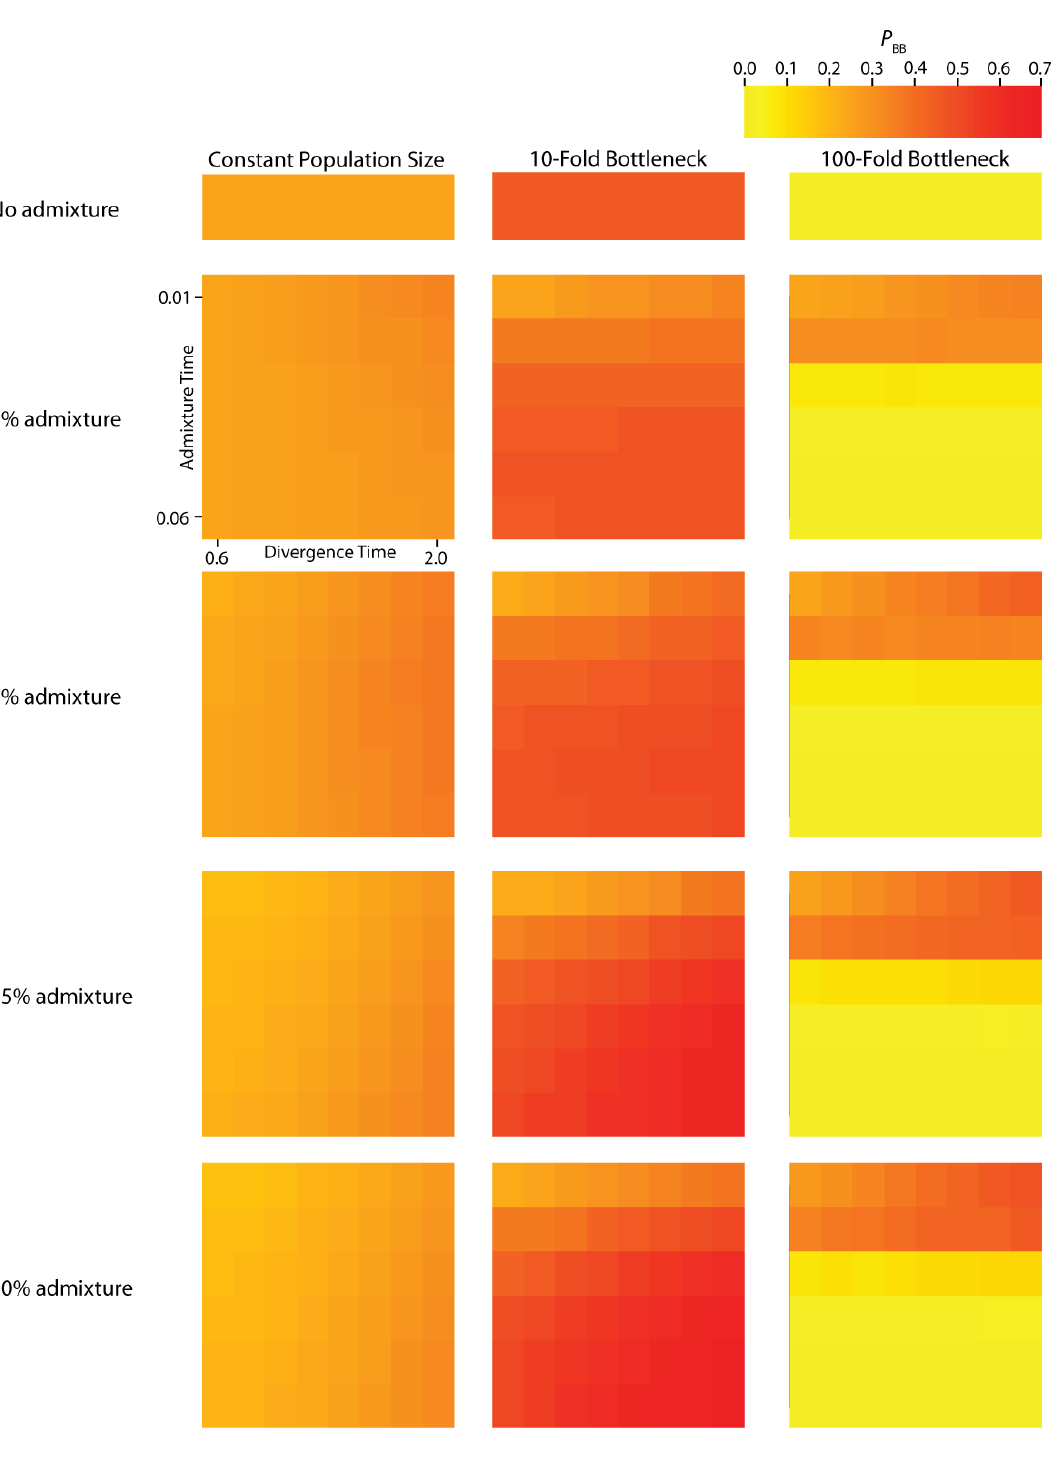
Figure 3. Simulated values for the proportion of total gene tree length that occurs in the two basal branches, or P . Each column corresponds to a different magnitude of founder BB event in the colonizing population. Each row represents differing levels of admixture between the colonizing and endemic populations. Finally, within each panel, squares correspond to different combinations of population divergence time and admixture time in the IAA